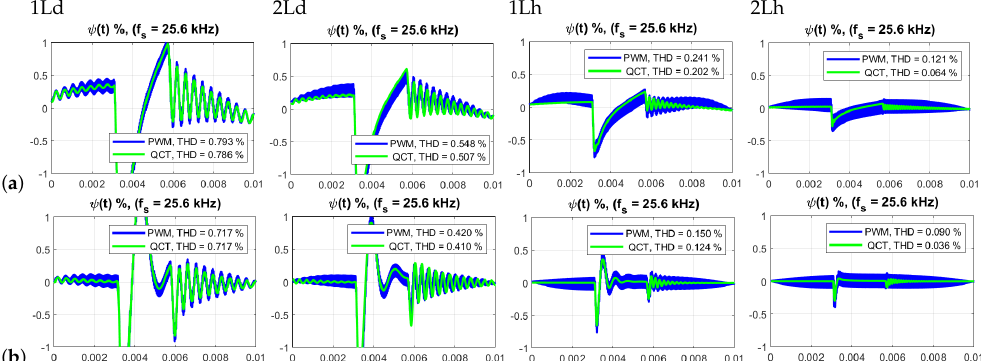
Figure 15. Distortion function ψ ( t ) and THD values of v out ( t ) in 1L (PD)/(PID) and 2L (P+P)/(PI+P) control systems optimized for rectifier RC load working at carrier frequencies f s = 25.6 kHz; ( a ) (PD)/(P+P) controller and ( b ) (PID)/(PI+P) controller.